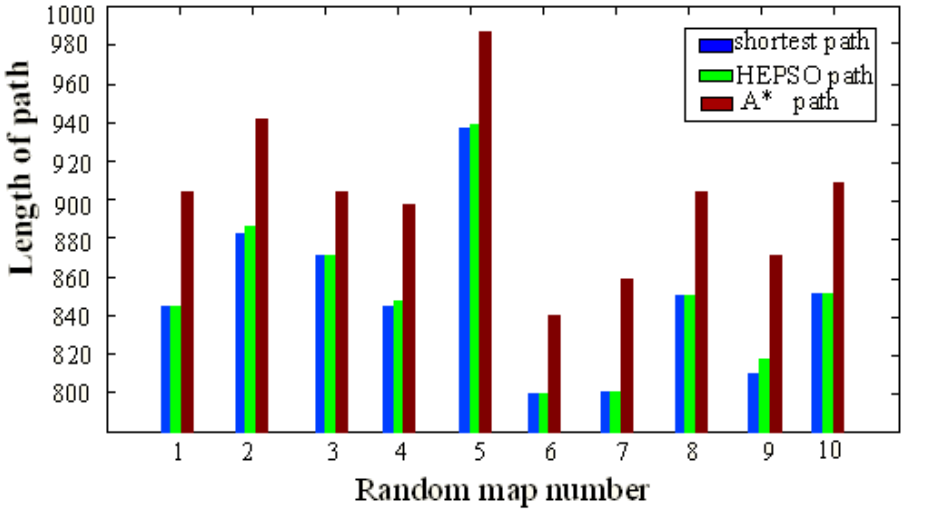
Figure 4. Comparison of path length between A* and HEPSO on random obstacles